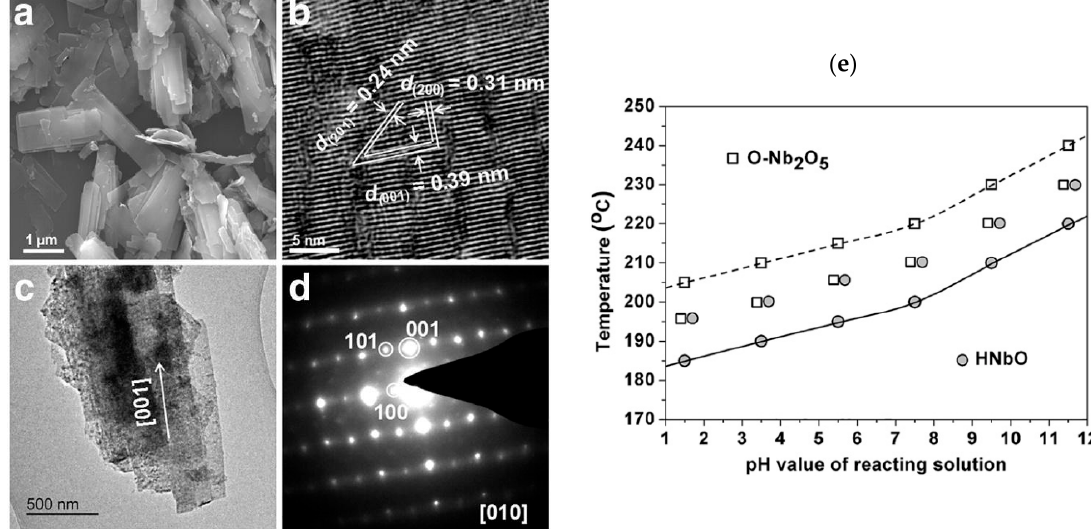
Figure 1. O-Nb 2 O 5 microscopies images of ( a ) field emission scanning electron microscopy (FE-SEM), ( b ) high-resolution transmission electron microscopy (HRTEM), ( c ) transmission electron